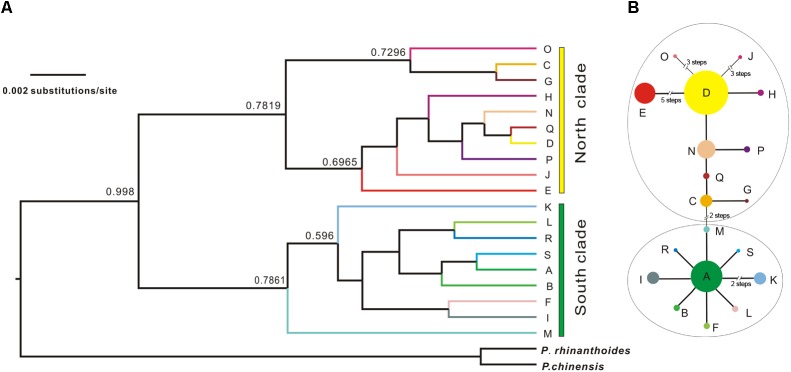
Bayesian tree of L. tibetica with P. rhinanthoides and P. chinensis as an outgroup, based on analysis of cpDNA sequences. (A) Bayesian tree of 19 L. tibetica lineages and two Pedicularis species: the numbers at the branches are posterior probability values. (B) maximum-parsimony median-joining network of the genealogical relationship among the 19 cpDNA haplotypes. Each circle denotes a single haplotype, shown with the area in proportion to its frequency. The numbers near the slashes across network branches indicate the number of mutational steps. The remaining branches represent single mutational steps.